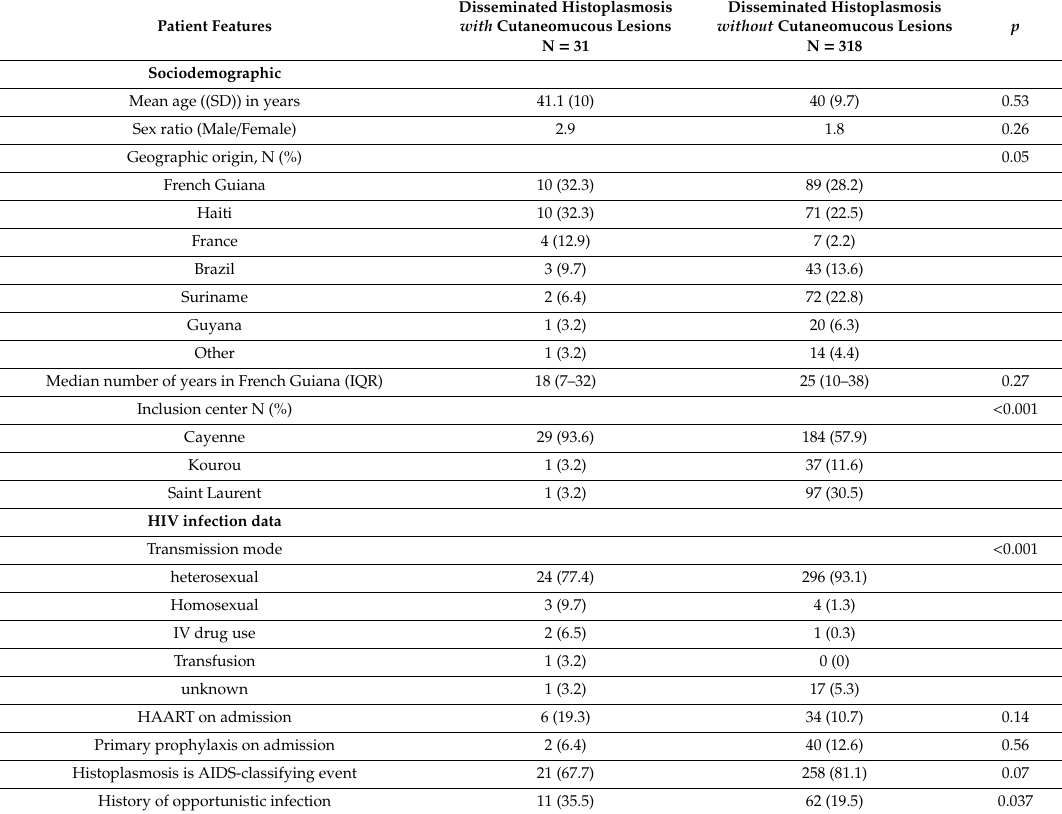
Table 1. Comparison of disseminated histoplasmosis with and without cutaneomucous